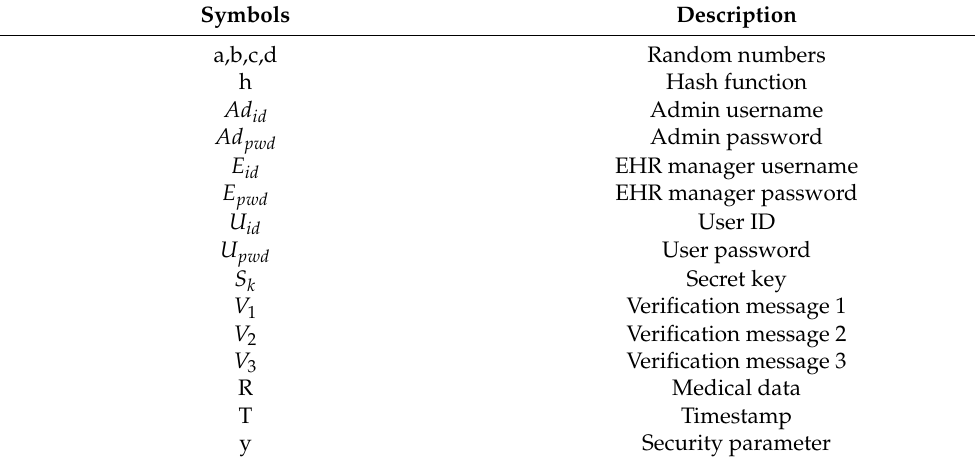
Table 2. Symbols